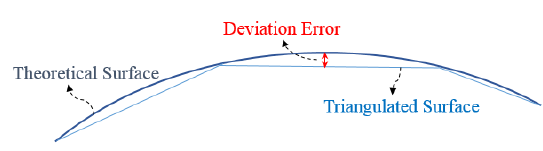
Figure 2. deviation error between the mesh and the estimated best shape